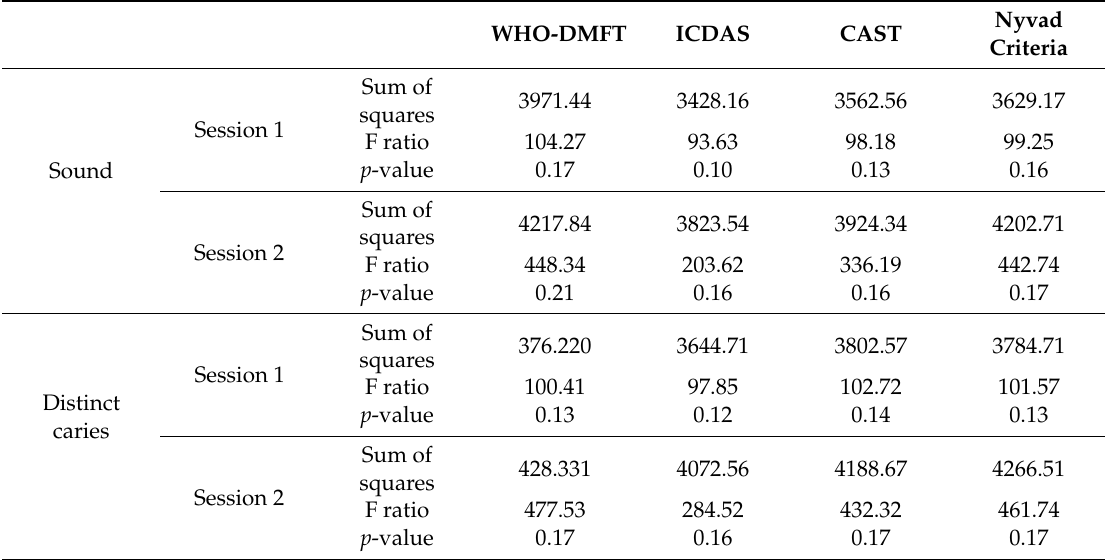
Table 4. Inter-examiner reliability: Analysis of variance on the four examiners using the different